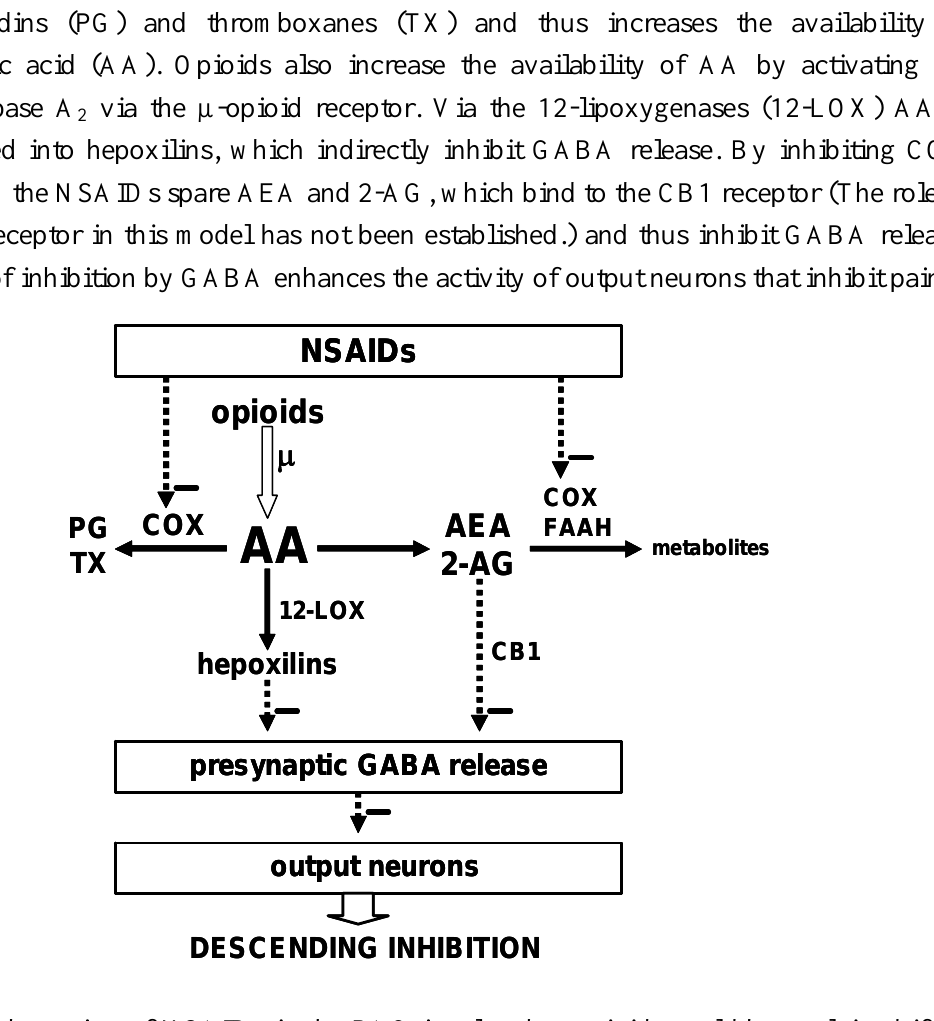
Figure 1. Proposed model for the interaction of NSAIDs, opioids and cannabinoids in the descending pain control system to induce analgesia. Minus symbols indicate